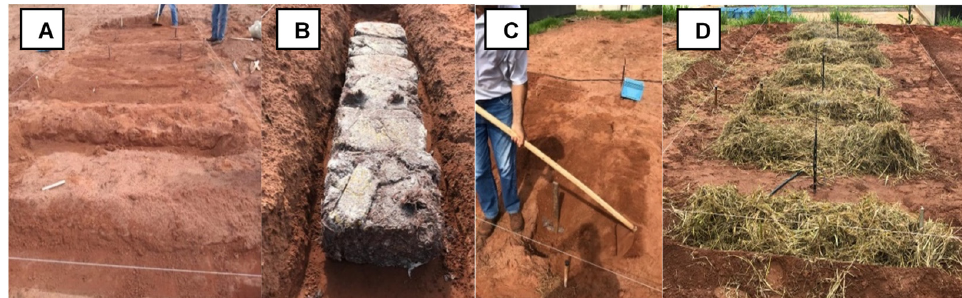
Figure 1. Agaricus subrufescens produced in the field: ( A ) furrow opening in the soil; ( B ) addition of the colonized compost in the furrow; ( C ) covering the compost with the same and soil removed; ( D ) covering the casing layer with straw (Junior et al. [16]).